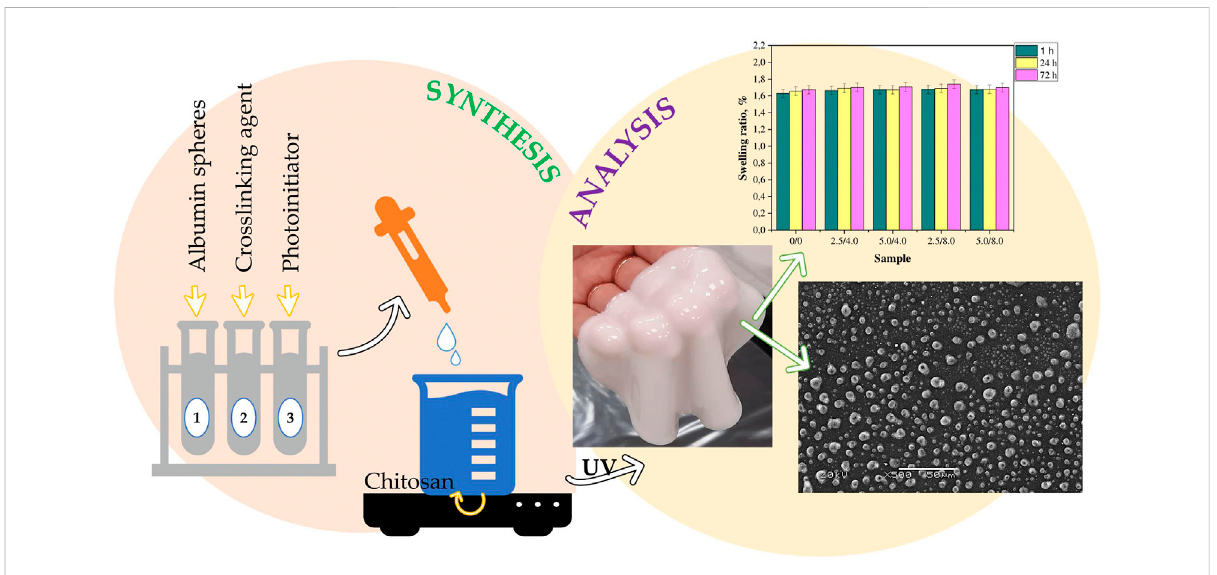
FIGURE 3 Physicochemical Characteristics of Chitosan-Based Hydrogels Containing Albumin Particles and Aloe vera Juice as Transdermal Systems Functionalized in the Viewpoint of Potential Biomedical Application. A brief diagram of the hydrogel synthesis process. Example, scanning electron microscopy images, and results of swelling studies of obtained